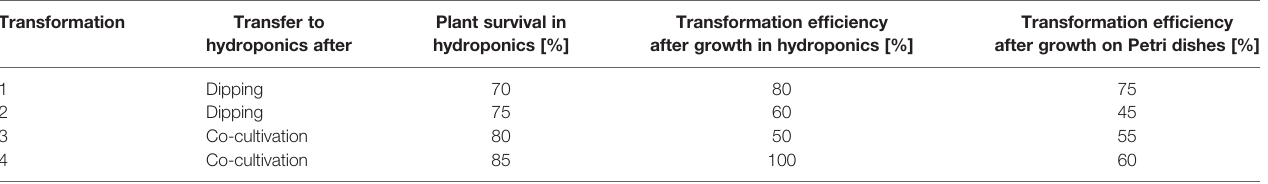
TABLE 1 | Lotus japonicus hairy root transformation ef fi ciency and plant survival after growth in hydroponic culture. Transformation Transfer to Plant survival in Transformation ef fi ciency Transformation ef fi ciency hydroponics after hydroponics [%] after growth in hydroponics [%] after growth on Petri dishes [%] 1 Dipping 70 80 75 2 Dipping 75 60 45 3 Co-cultivation 80 50 55 4 Co-cultivation 85 100